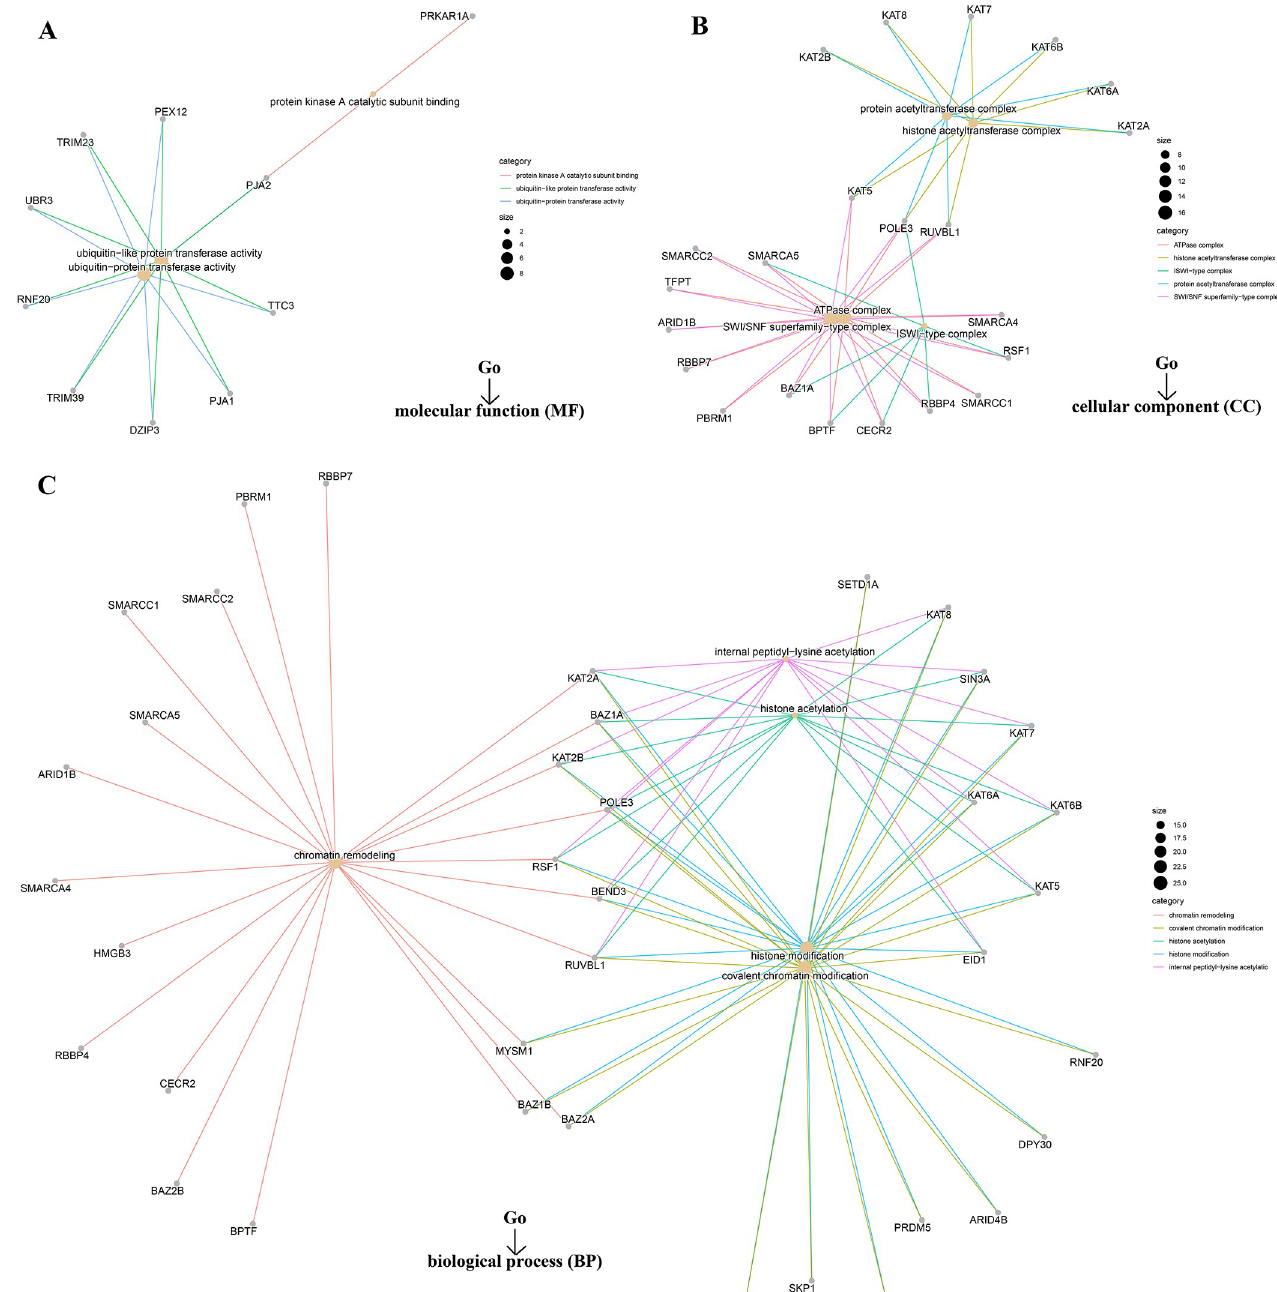
Fig 14. Go analyses of SMARCA1-related genes in different cancers. (A) The cnetplots for the molecular function (MF) data; (B) The cnetplots for the cellular component (CC) data; (C) The cnetplots for the biological process (BP) data. https://doi.org/10.1371/journal.pone.0274823.g014 PLOS ONE | https://doi.org/10.1371/journal.pone.0274823 September 20,